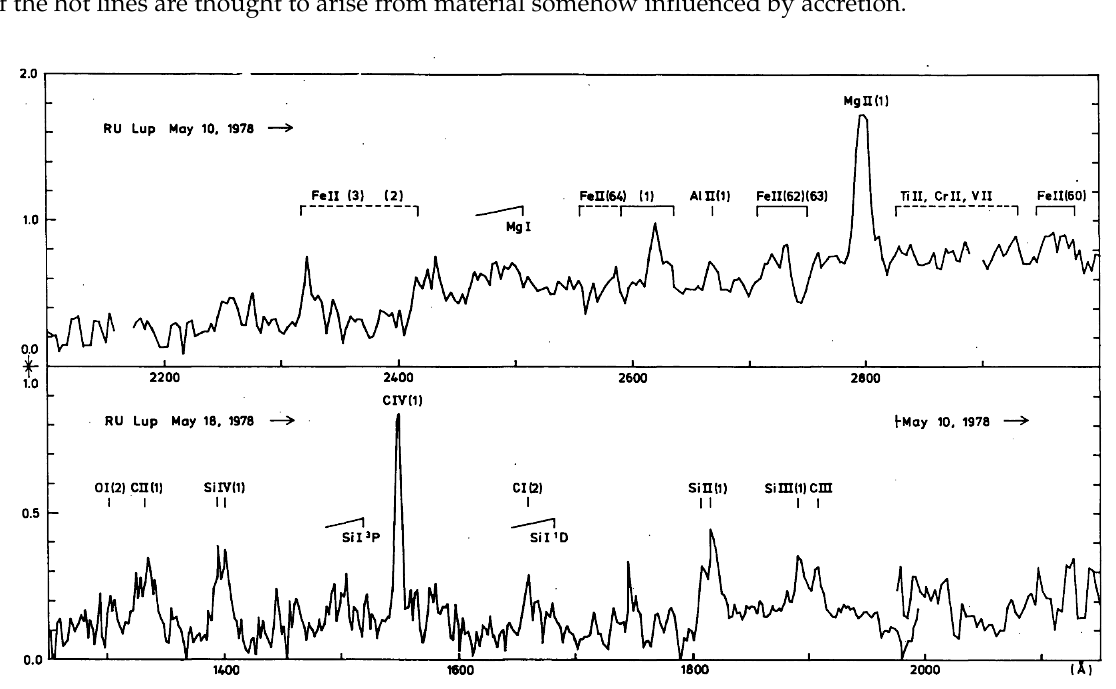
Figure 1. IUE spectrum of RU Lup (flux unit: 10 − 13 ergcm − 2 s − 1 Å − 1 ) with the main features labeled, one of the first high-fidelity FUV spectra of a classical T Tauri star (CTTS). From Gahm et al. [38]. Reproduced with permission c (cid:13)